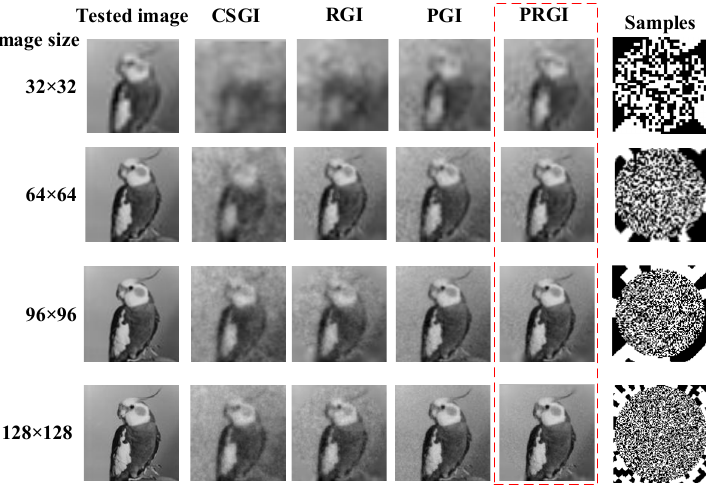
Figure 5. Reconstructed results of ‘CSGI’, ‘PGI’, ‘RGI’ and ‘PRGI’ under different image sizes.